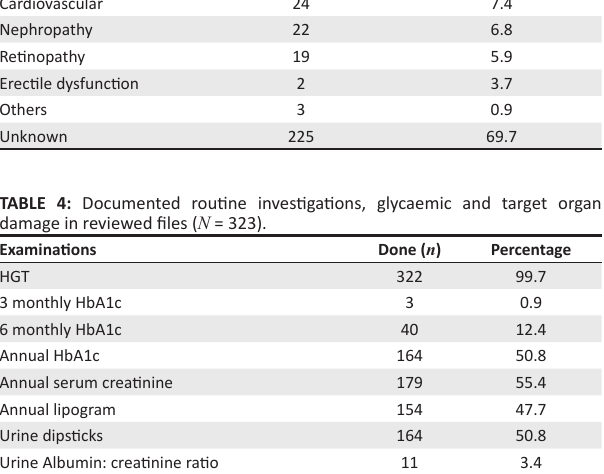
Urine Albumin: creatinine